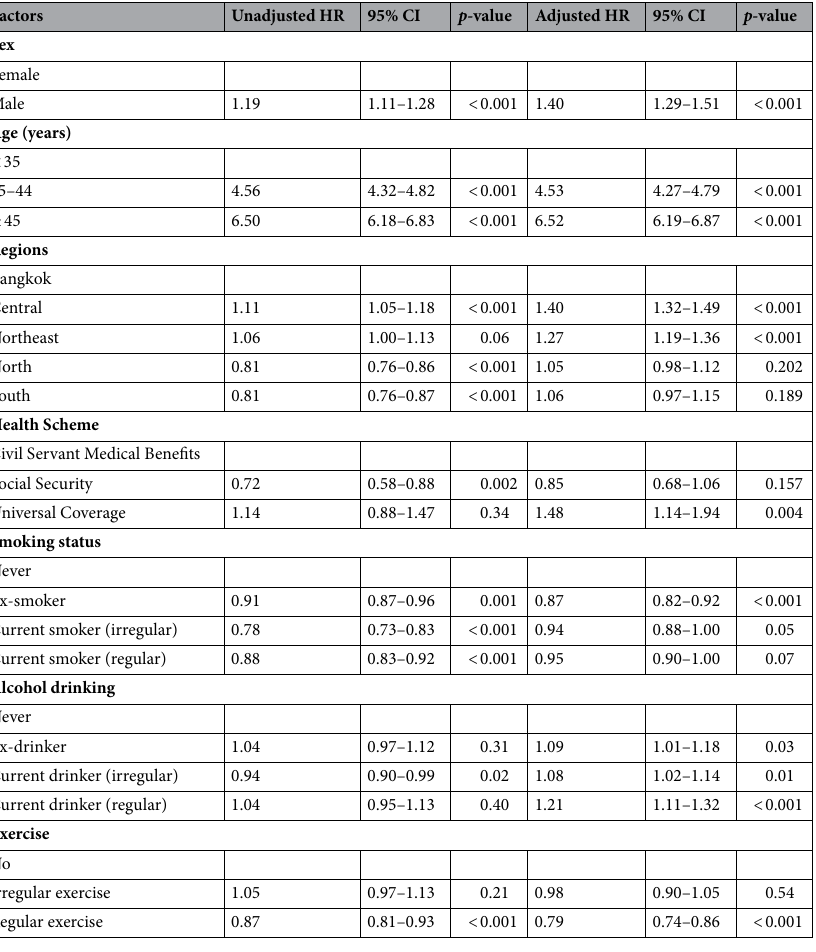
Table 3. Univariable and multivariable analysis of the association between demographic, behavioral, and clinical factors and the incidence of metabolic syndrome among RTA personnel. HR Hazard ratio, 95% CI 95% confidence